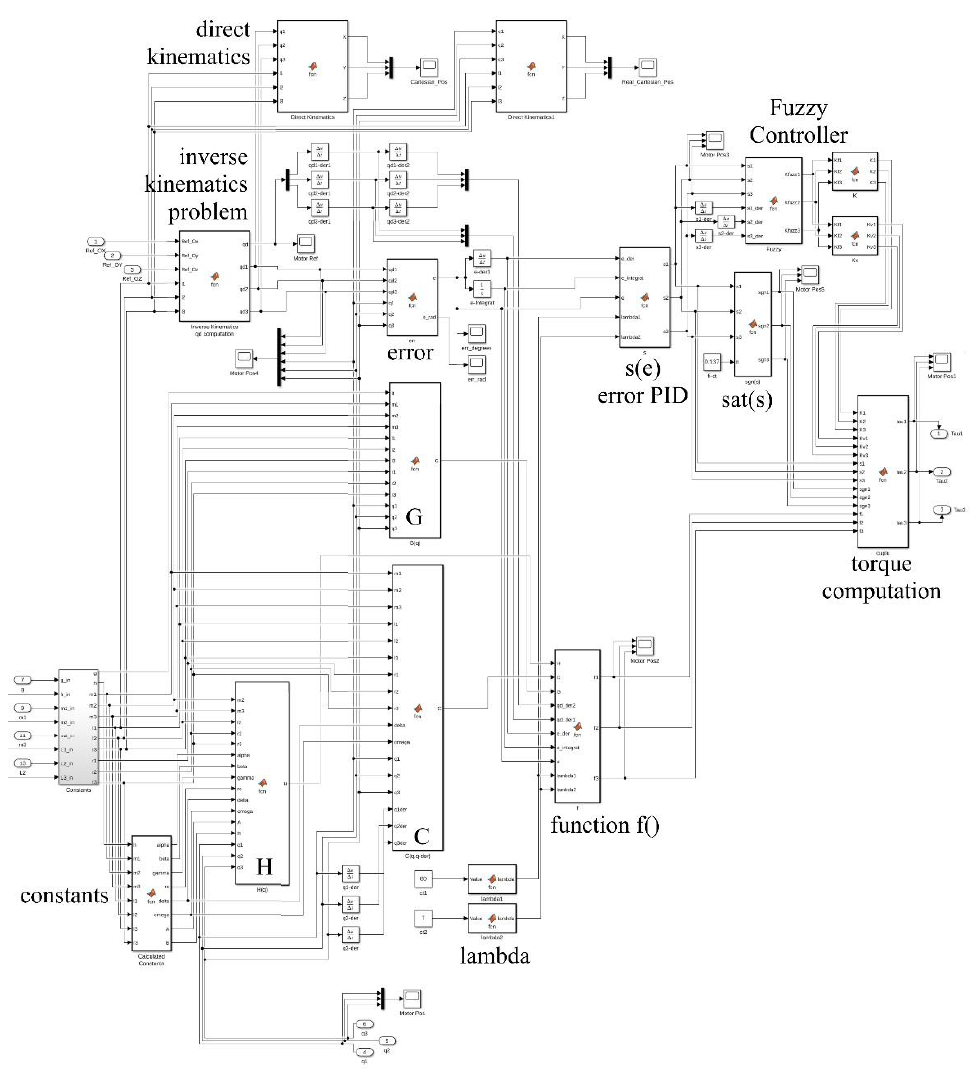
Figure 12. Constant values.